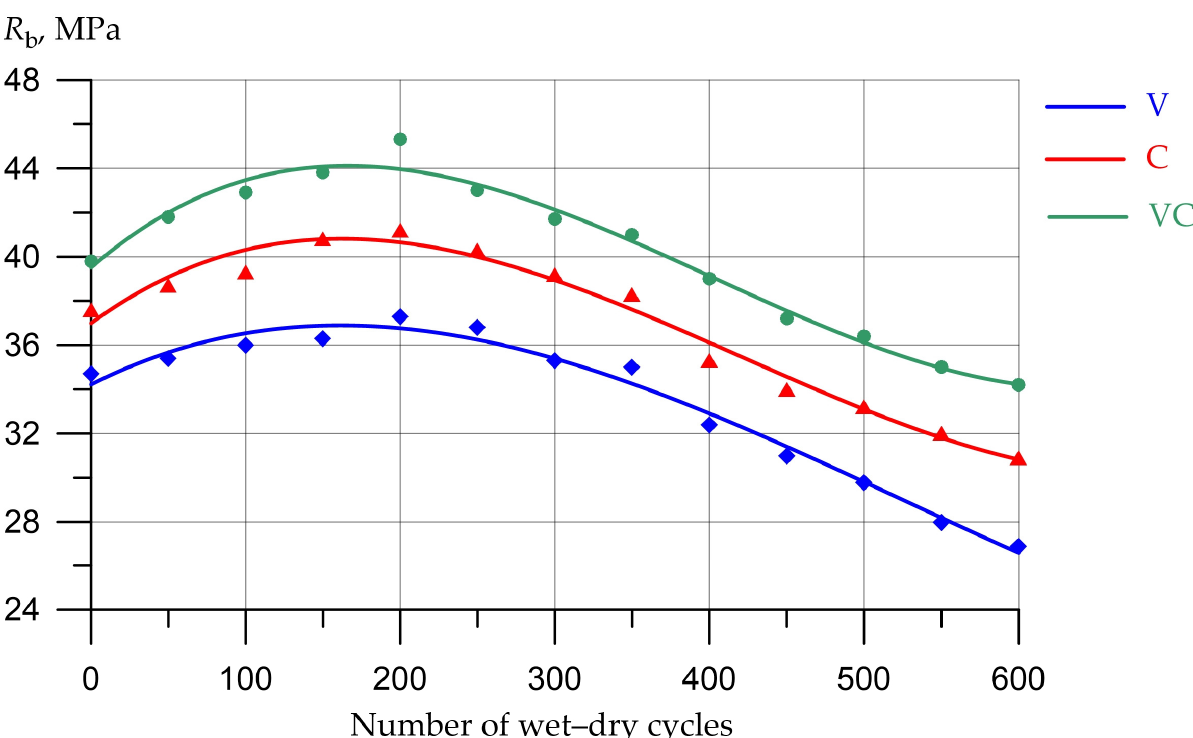
Figure 11. The dependence of the change in the prism compressive strength of vibrated, centrifuged, and vibrocentrifuged concretes on the number of moistening and drying cycles at pH 10.